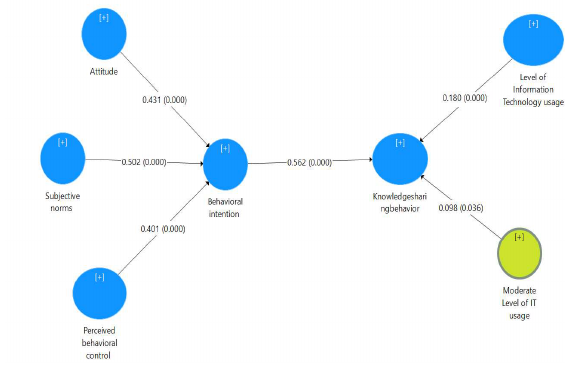
Fig. 5 . Moderate role of Level of IT